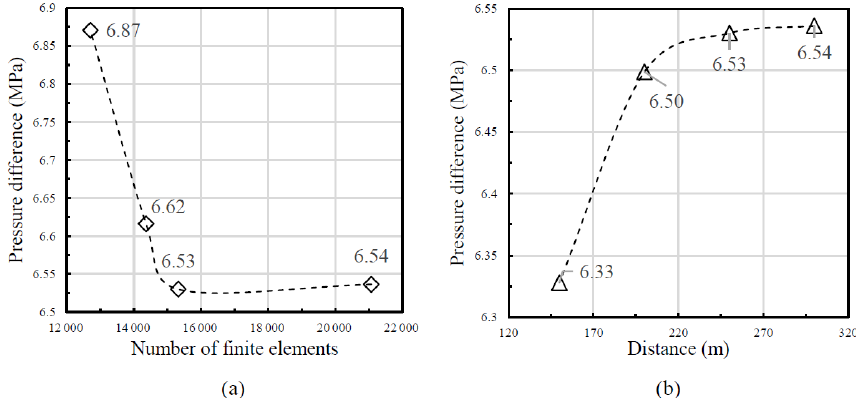
Figure 6. (a) Sensitivity analysis with respect to finite element mesh and (b) Sensitivity analysis with respect to distance between fracture zone and domain boundary.